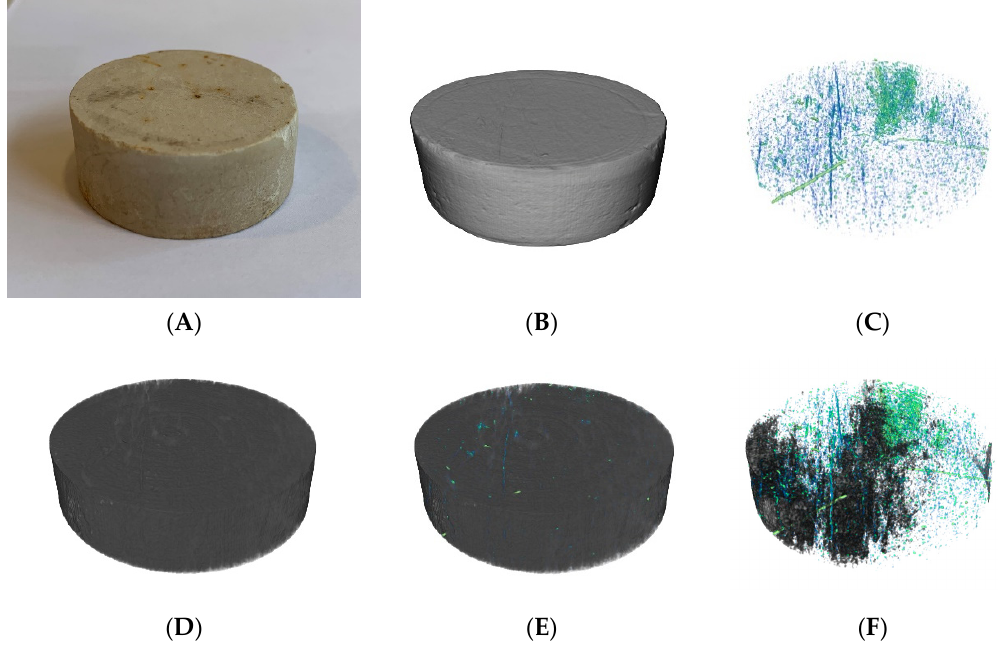
Energies 2021 , 14 , 5360 Figure 10. ( A ) photo of the core slice after flooding, ( B ) exterior of the core plug, ( C ) density variations, ( D ) qualitative fluid content, ( E ) fluid content superimposed on density variations, ( F ) fluid content that is highly likely to be the water phase.